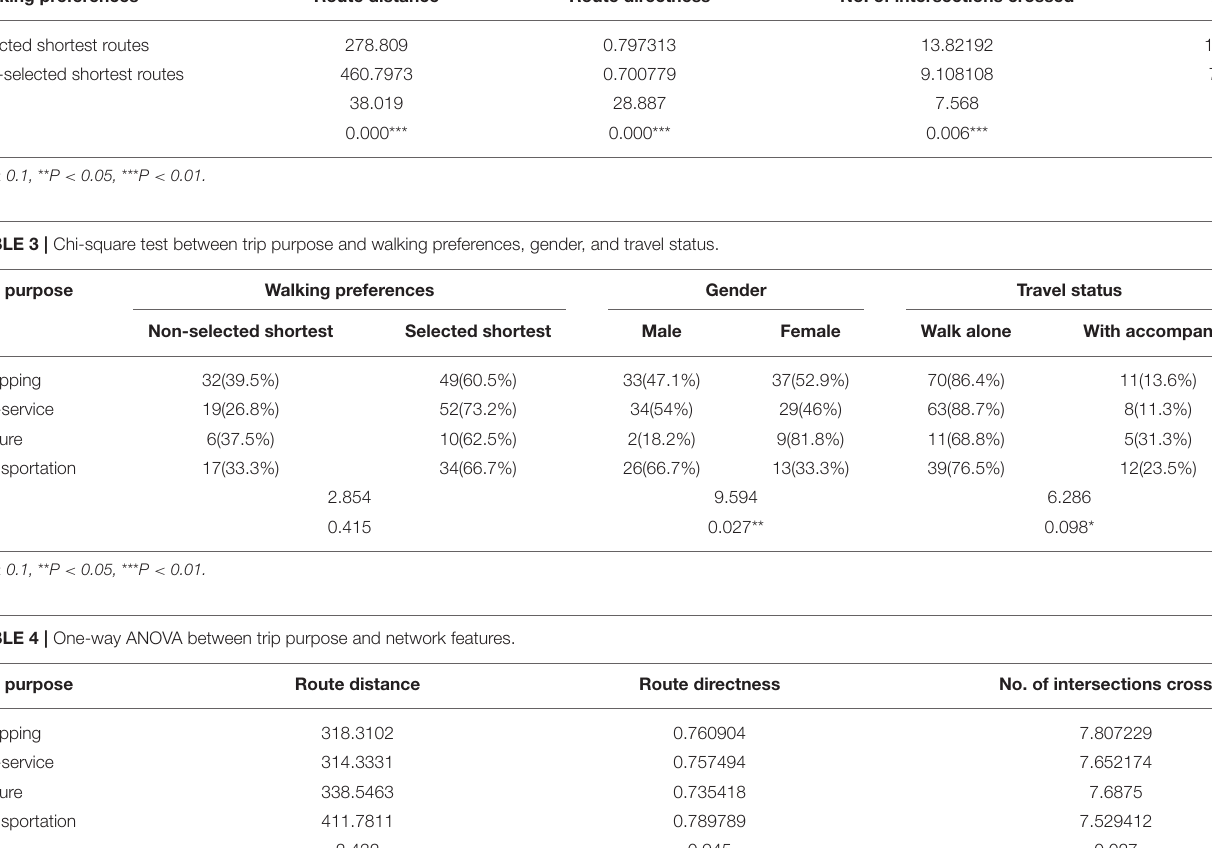
TABLE 2 | Differences in network features between selected and non-selected shortest routes. Walking preferences